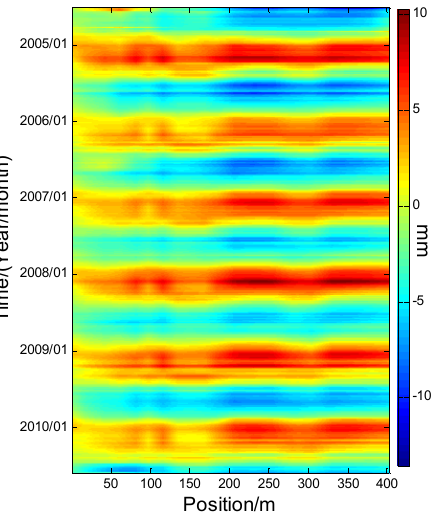
Figure 8. Interpolated horizontal displacement for the whole dam in the spatio-temporal domain.